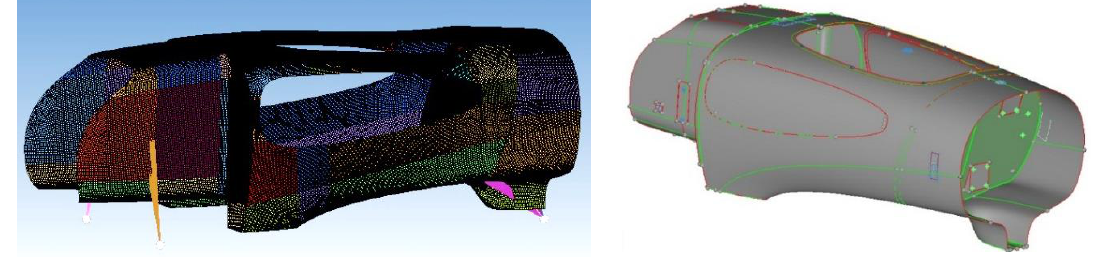
Figure 5. FEM shell elements mesh definition ( left ) and pre-processing geometry cleanup ( right ).